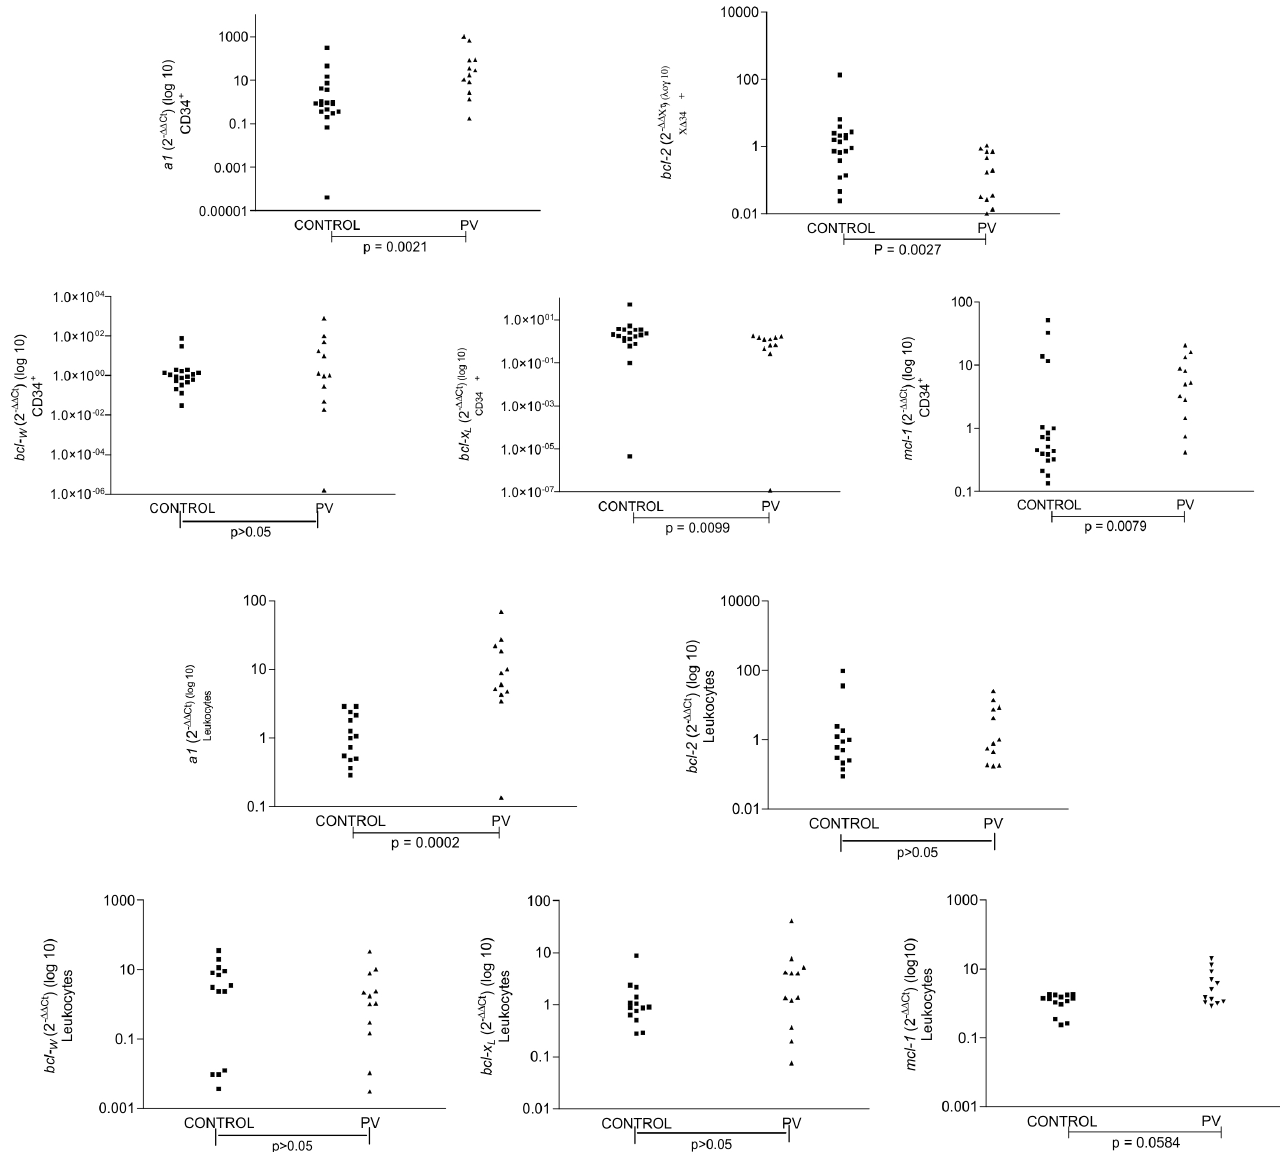
FIGURE 1 - Antiapoptotic genes expressed in CD34 + HSC and leukocytes from PV patients and controls. Βeta-actin gene was used as endogenous control. The genes relative expression were detected by real time PCR and results were given as 2 -∆∆Ct . The horizontal lines represent the median of gene expression in each group analyzed. A1 and Mcl-1 are overexpressed (median: 22.6 and 5.2, respectively) in CD34 + HSC from PV patients in comparison with controls (median: 0.9 and 0.5, p=0.002 and p=0.008). Bcl-2 and Bcl-x mRNA levels were decreased in PV patients’ CD34 + HSC (0.18 and 1.19) in relation to controls (1.39 and 2.01; L p=0.006 and p=0.020). Patients’ leukocytes also showed an A1 gene expression augmentation (7.41, p=0.001). There were no statistically significant differences in mRNA levels of Bcl-2 , Bcl-x and Mcl-1 in patient leukocytes . No significant differences in L Bcl-w expression between controls and PV patient CD34 + HSC and leukocytes were detected (p >